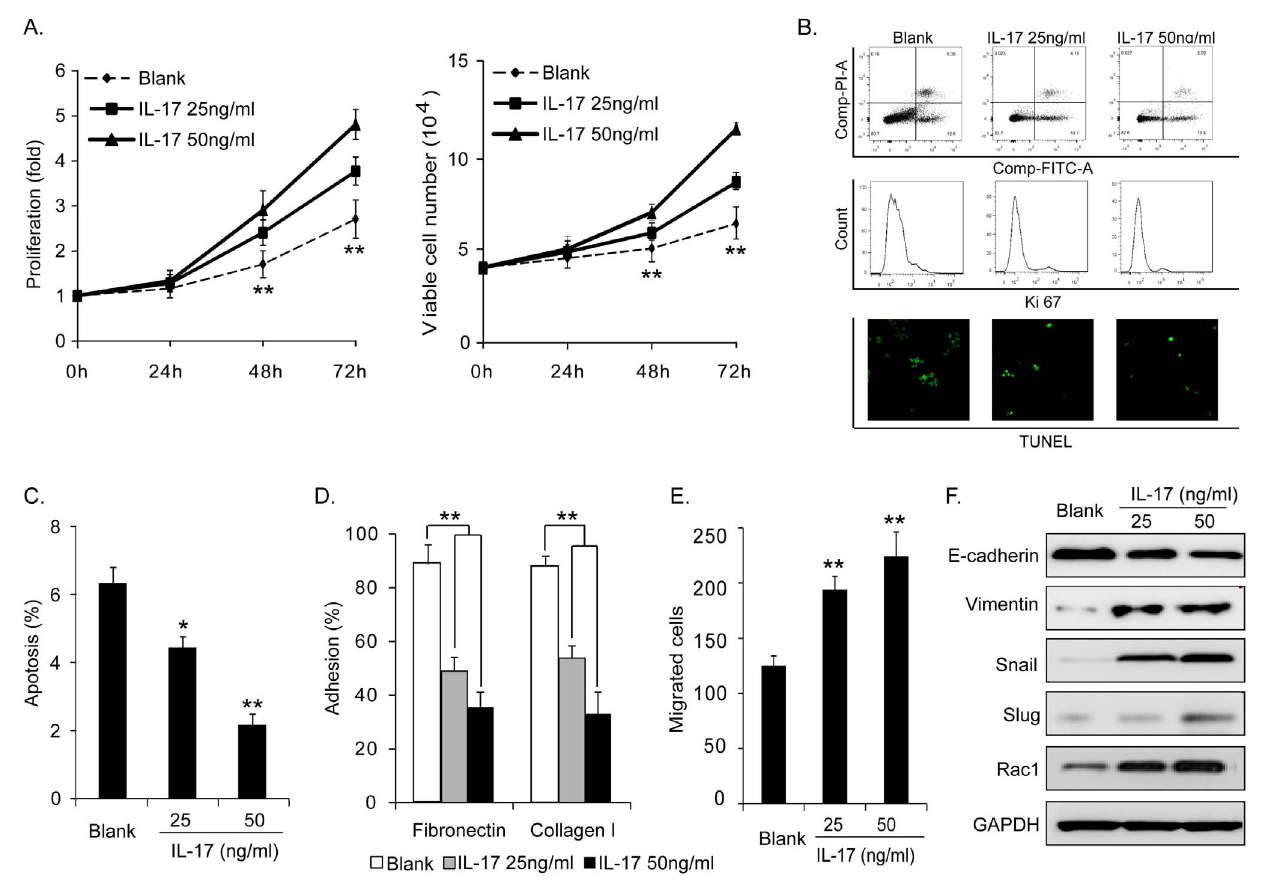
Fig. 1. Effects of IL-17 on proliferation, apoptosis, adhesion, migration and EMT properties of MM1S cells. (A) IL-17 induced cell proliferation was analyzed by WST-8 assays (left) and Trypan Blue exclusion viable cell assay (right). (B) IL-17 inhibited cell apoptosis determined by Annexin-V binding assay (top), Ki-67 staining (middle), and TUNEL assay (bottom). (C) Canonical histogram of apoptotic rate characterized by Annexin-FITC positive cells was shown. (D) IL-17 decreased cell adhesion to fibronectin and collagen I. (E) IL-17 increased cell migration. (F) IL-17 induced EMT and Rac1 expression of cells. Epithelial marker E-cadherin, mesenchymal marker Vimentin, EMT transcription factors Snail and Slug, and Rac1 expression were detected by western blot analysis. Note all the effects induced by IL-17 were in a dose-dependent manner. (**P , 0.01, *P , 0.05, Figure is representative of 3 experiments with similar